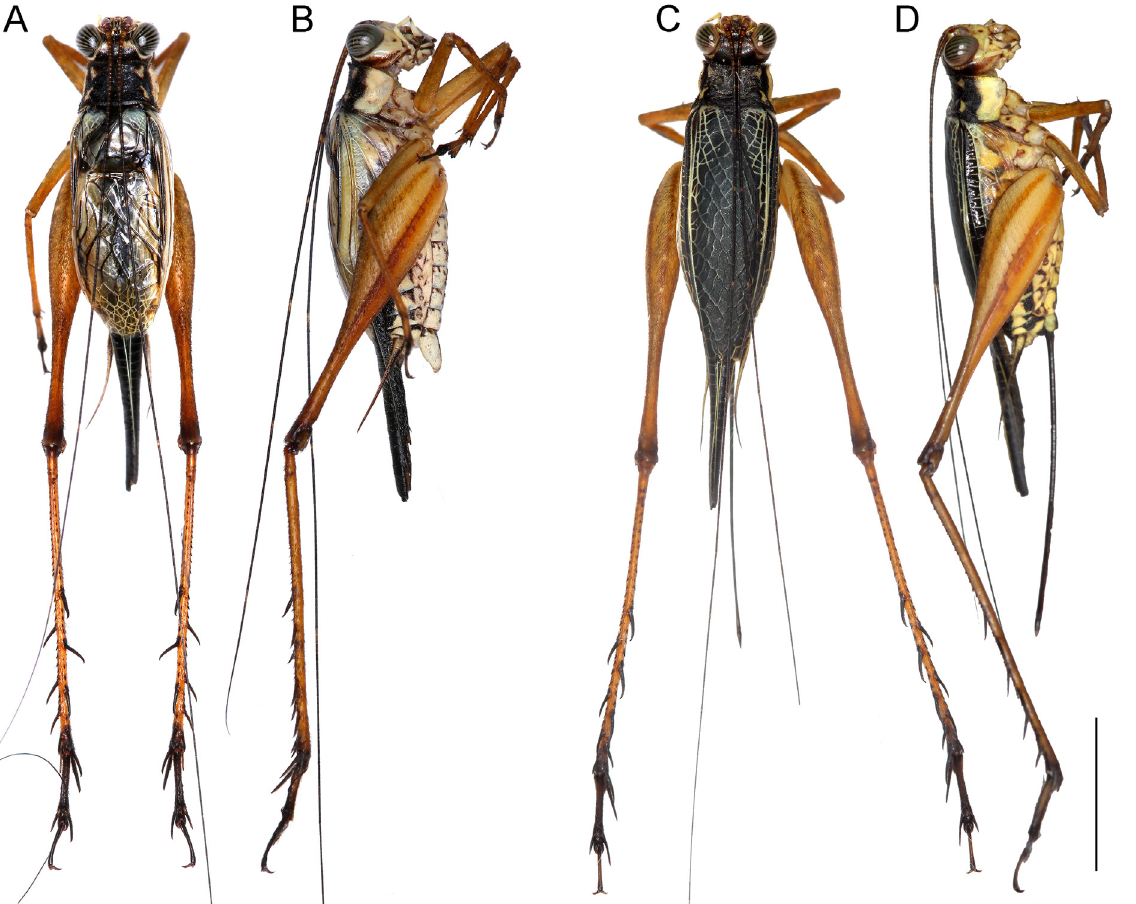
Fig. 1. Habitus of Nisitrus vittatus (Haan, 1844) in dorsal (A, C) and lateral (B, D) views. A–B . ♂. C–D . ♀. Scale bar = 5